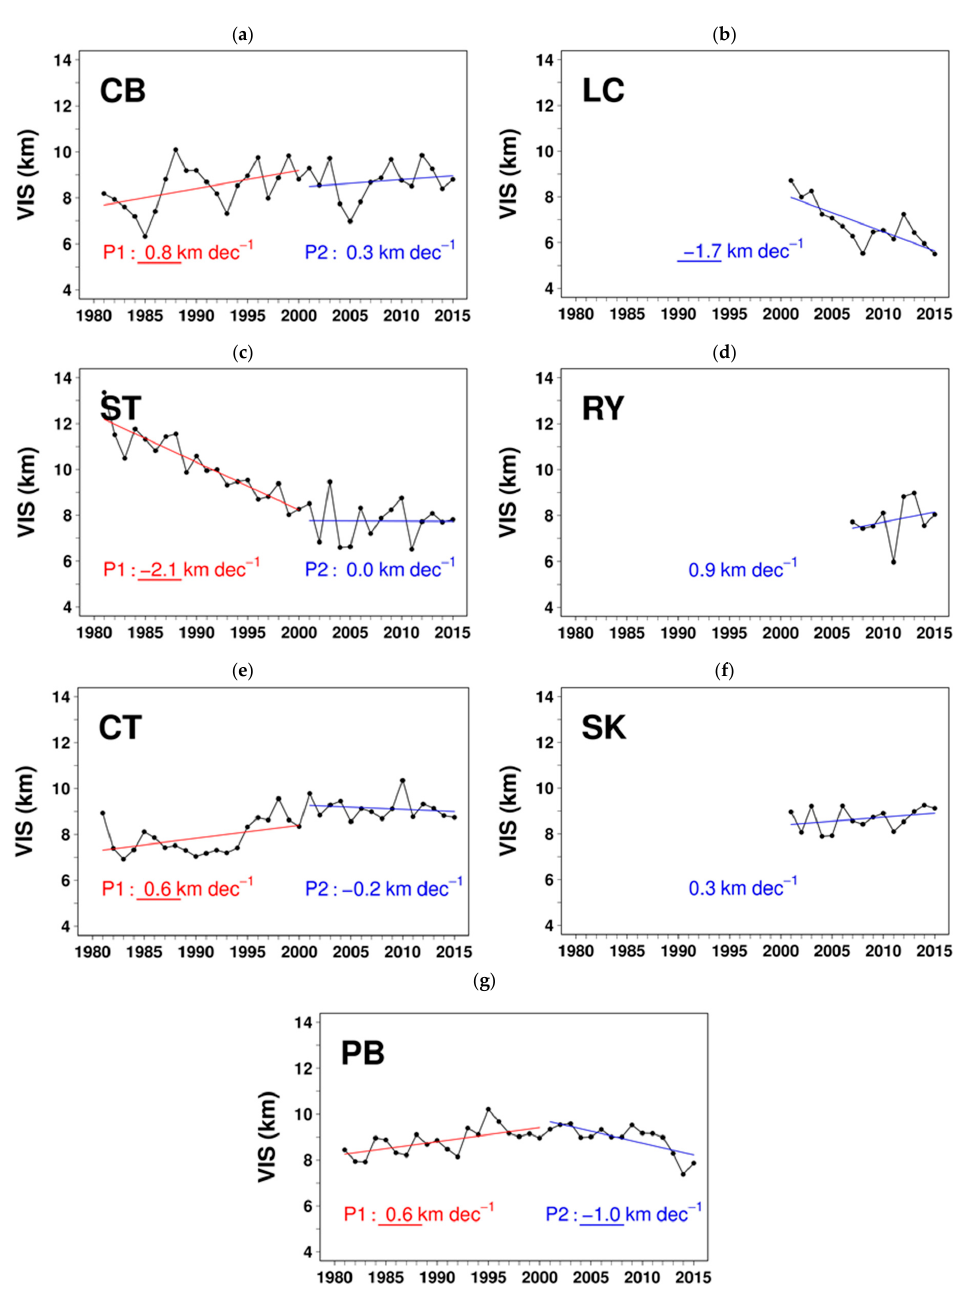
Figure 9. Trends in visibility at ( a ) Chon Buri (CB); ( b ) Laem Chabang (LC); ( c ) Sattahip (ST); ( d ) Rayong (RY); ( e ) Chanthaburi (CT); ( f ) Sa Kaeo (SK); ( g ) Prachin Buri (PB). For CB, ST, CT, and PB, the red and blue lines are the linear fits over the periods of 1981–2000 and 2001–2015, respectively. For the other stations, the linear fits are limited to recent years (here, 2001 or after). The underlined values are of statistical significance at a 0.05 level against the null hypothesis of no trend.